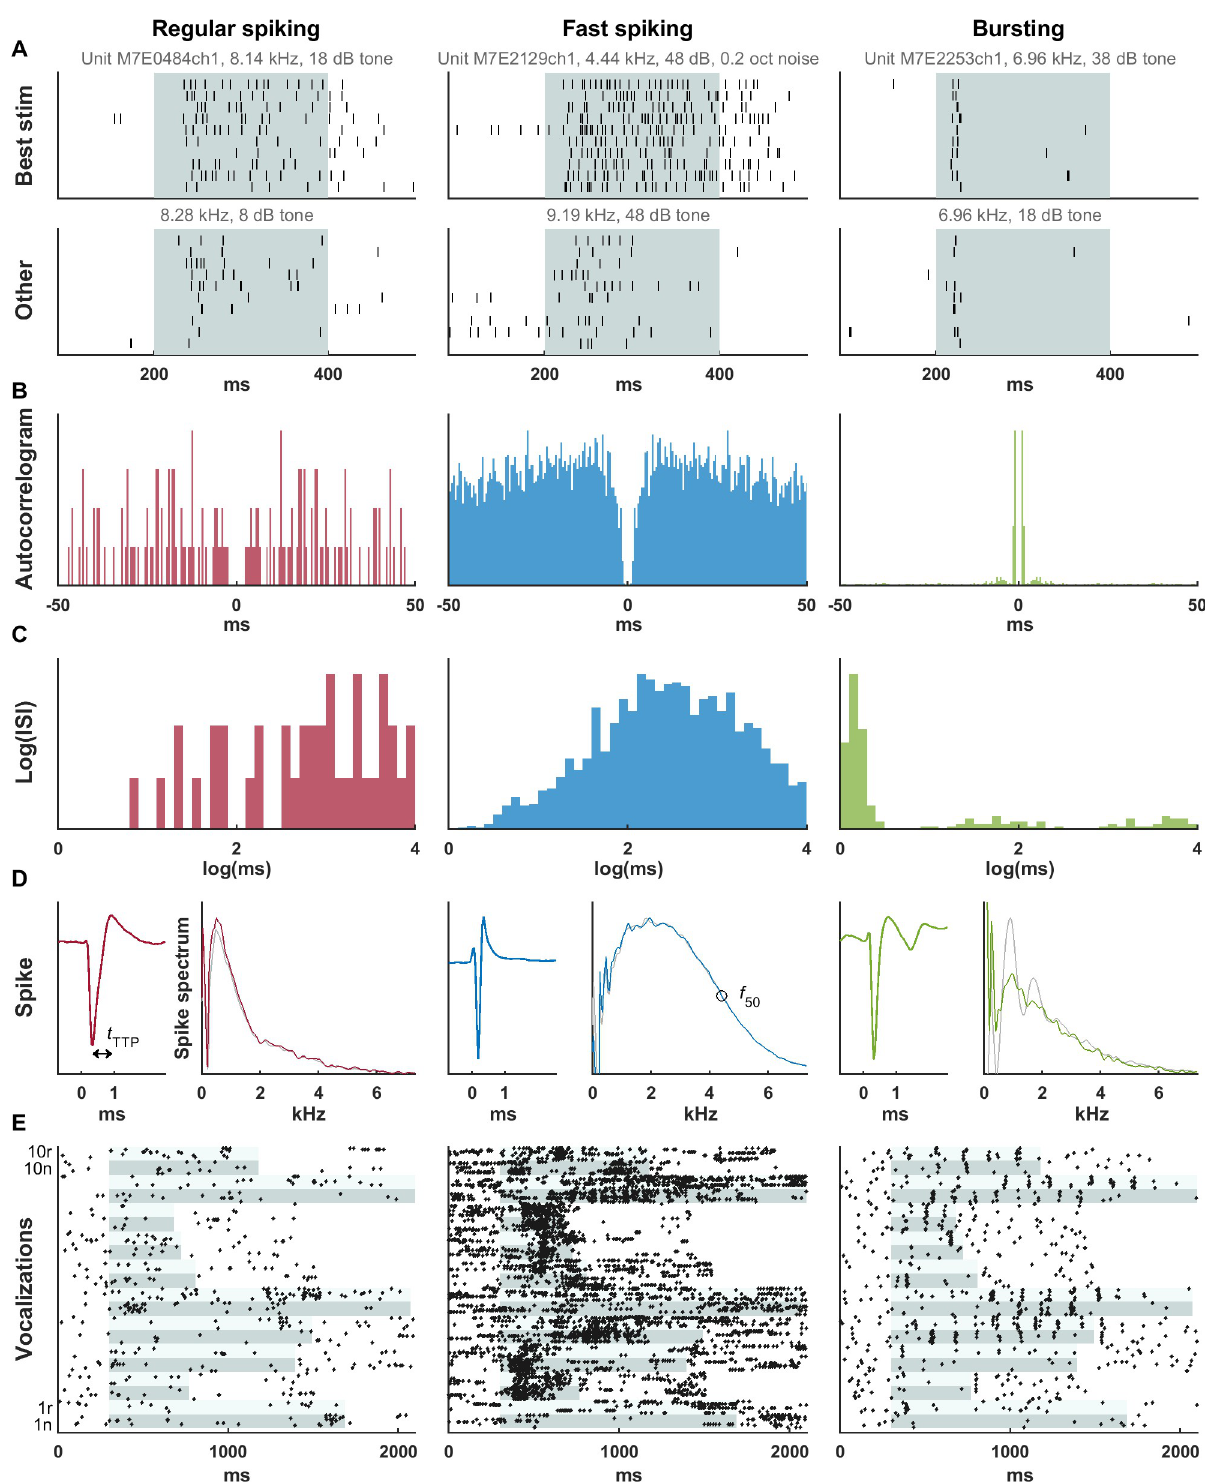
Fig 1. Examples of 3 unit types discerned from extracellular recordings—RS, FS, and Bu. AU : AbbreviationlisthavebeencompiledforthoseusedinFigs 1 to 8 ; S 2 toS 5 ; andS 8 : Pleaseverifythatallentriesarecorrect : The RS and FS units had relatively sustained responses at best frequency, intensity, and bandwidth, and less sustained responses to less optimal stimuli. However, the Bu unit responded transiently even to the relatively optimized simple stimulus (A) as well as conspecific vocalizations (E). Stimulus duration is shown in light aqua, with each band encompassing 10 trials; adjacent stimuli in (E) are shown in alternating shades. The Bu unit had a peak at a few milliseconds on the autocorrelogram